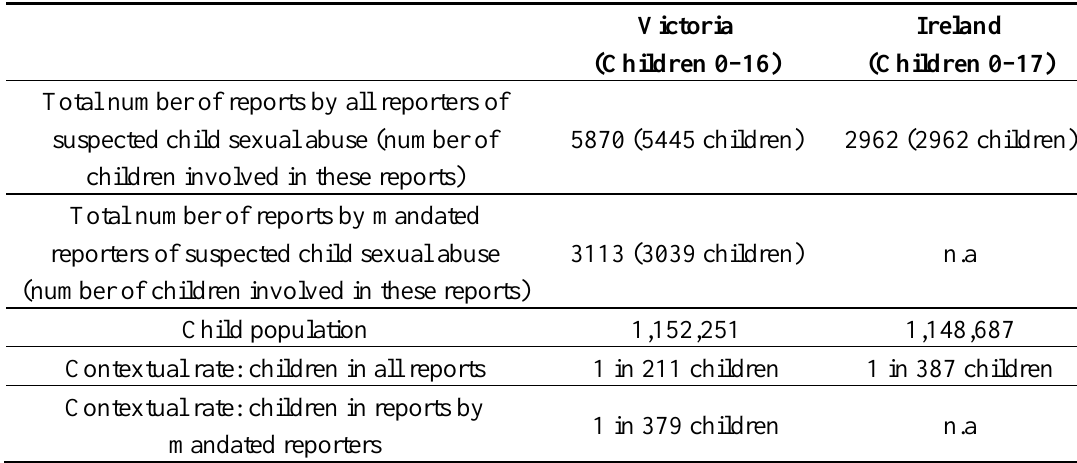
Table 3. Rates of children in reports of child sexual abuse,